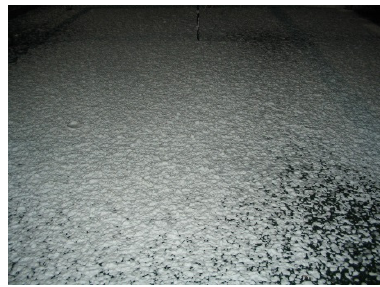
Figure 4. Shape of the discharging compressed air foam of specimen I.